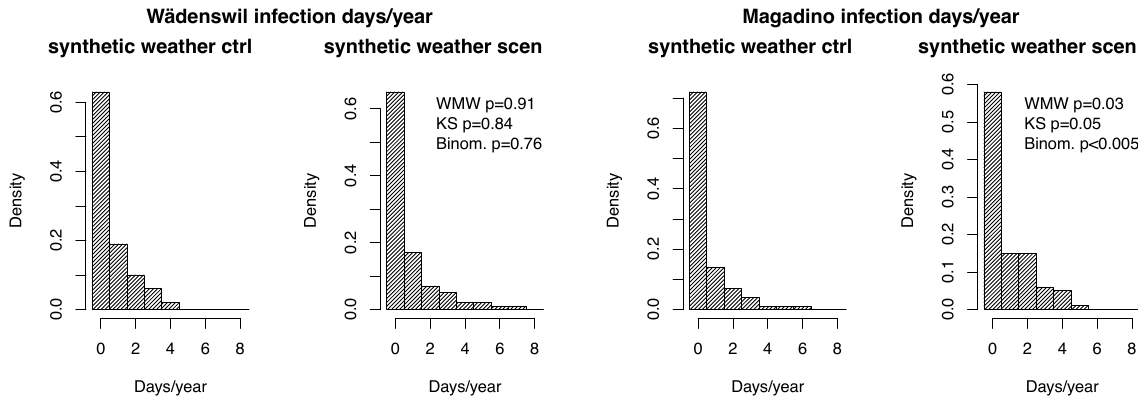
Fig. 8. As Fig. 3 (bottom row), but for the number of fire blight infection days per year from synthetic weather for present (“ctrl”) and future (“scen”) at the stations W¨adenswil (left panels) and Magadino (right